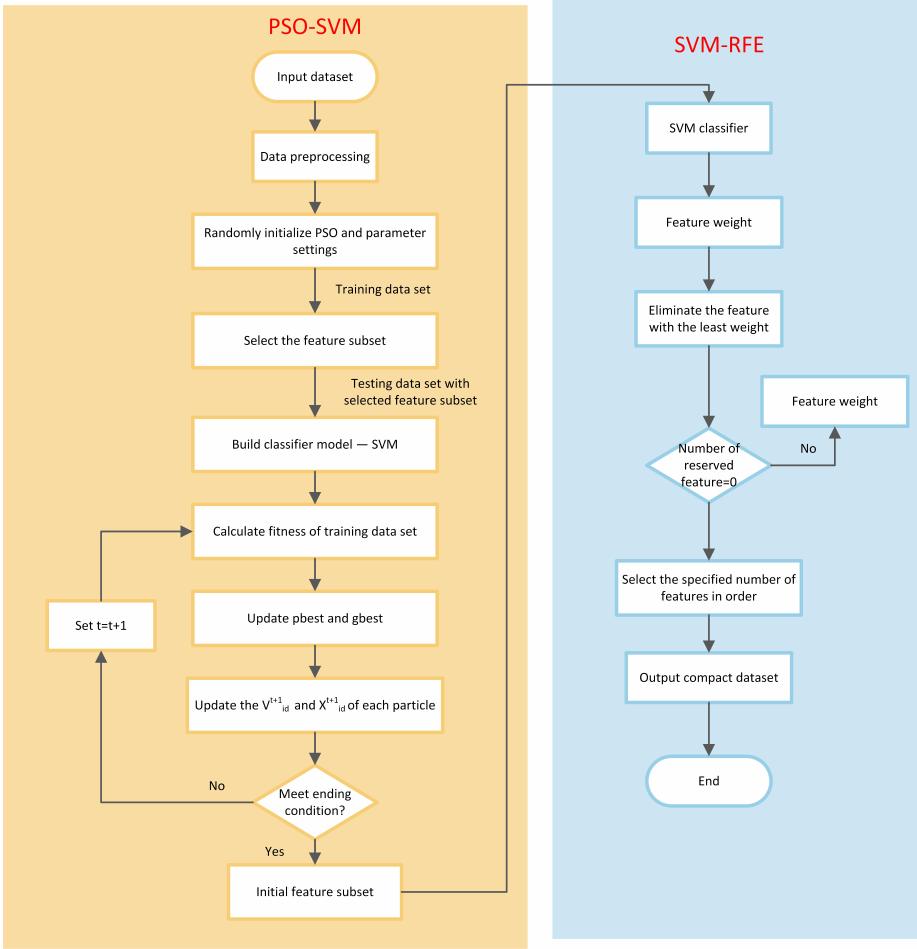
Figure 1. The proposed PSO-SVM-RFE method for feature